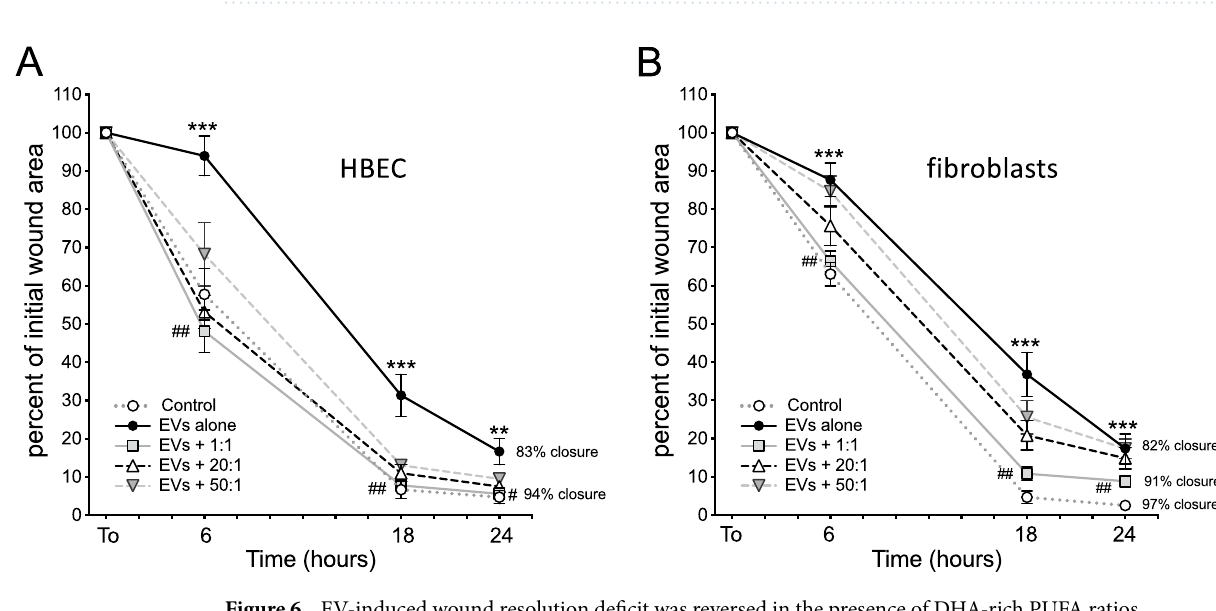
Figure 6. EV-induced wound resolution deficit was reversed in the presence of DHA-rich PUFA ratios. Circular wounds made in confluent monolayers of HBEC ( A ) or HLF ( B ) were allowed to heal in the presence of control medium, DE-derived EVs, or EVs with one of three PUFA ratios. The wound area was analyzed over the course of 24 h, compared to the size of the initial wound, and percent closure was calculated. DHA-rich PUFA ratios (1:1) significantly reversed the DE-mediated wound closure deficit. Results shown are means for 3 independent experiments, 12 ( A ) or 9 ( B ) technical replicates per condition. **p < 0.01, ***p < 0.0001 vs. Control, ## p < 0.001 vs. EVs alone at corresponding time points, (Student’s t test for pairwise